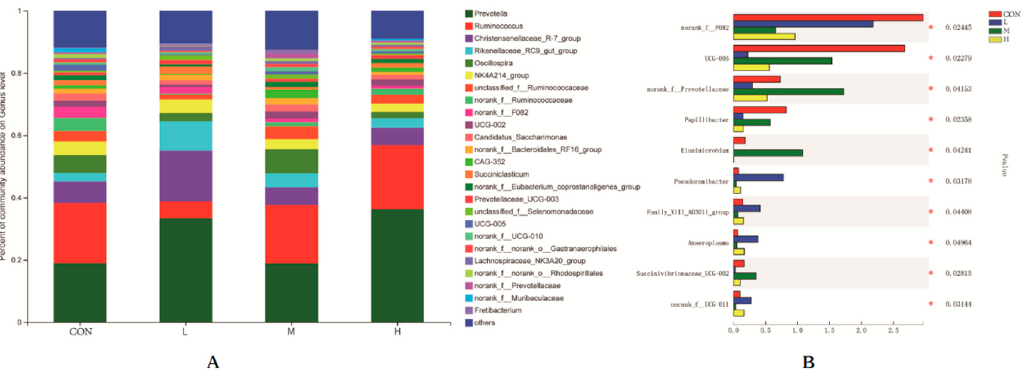
Figure 3. Composition ( A ) and difference ( B ) of rumen microbial genera level in lambs. Only the dominant genera (those with relative abundances ≥ 1%) of rumen bacteria are shown. Corrected p < 0.05 is marked with *. CON, L, M and H represent the substitution of 0, 20, 40 and 60% of maize silage with mulberry silage, respectively.